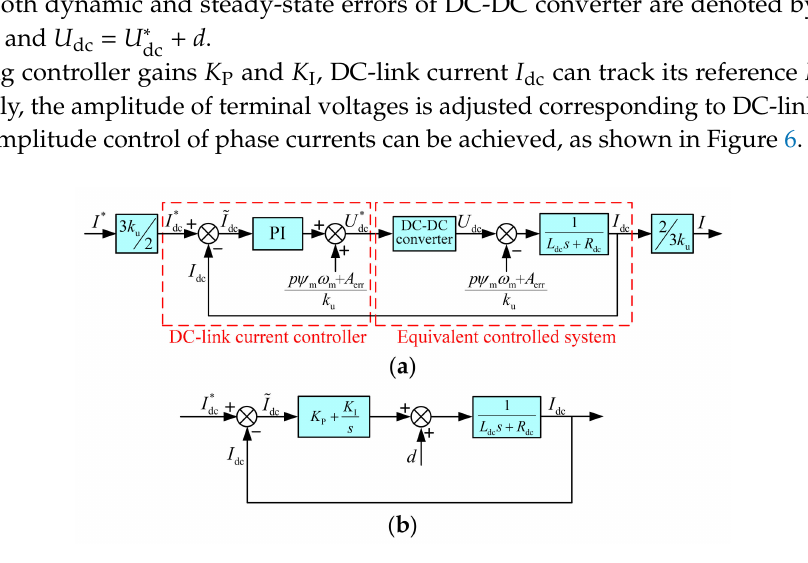
Figure 6. Implementation of DC-link current control. ( a ) schematic diagram of control system; ( b ) simplified